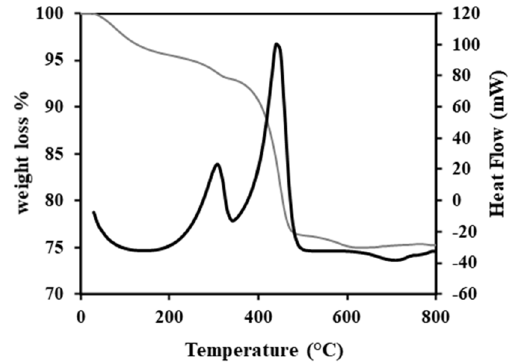
Figure 1. TGA profile of the spent catalyst.